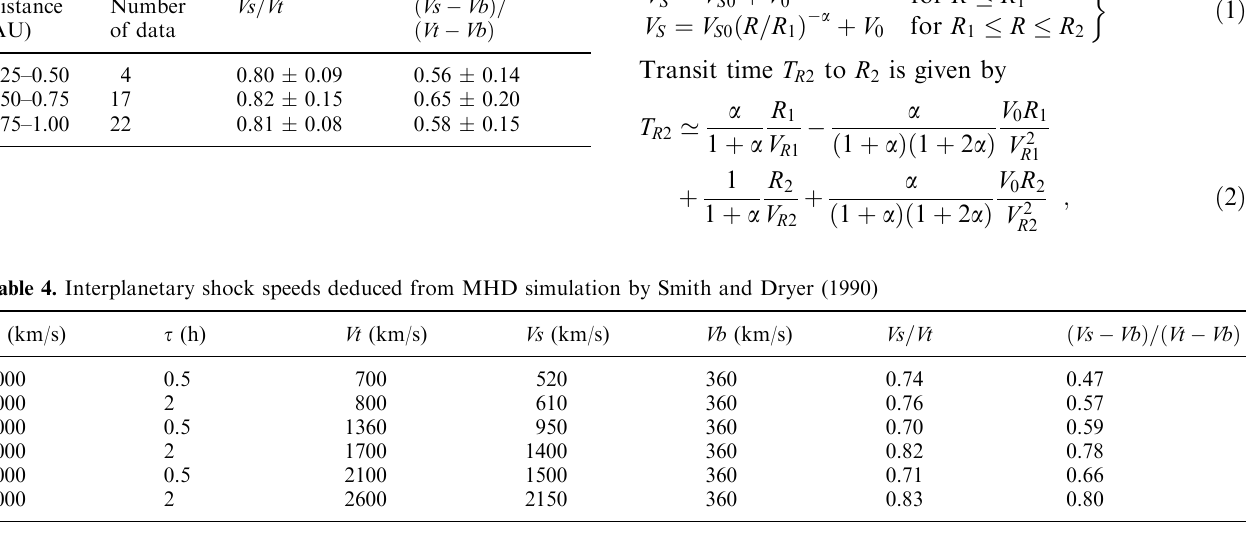
Table 3. Distance dependence of ratios between transit and local shock speeds Distance Number (AU) of data